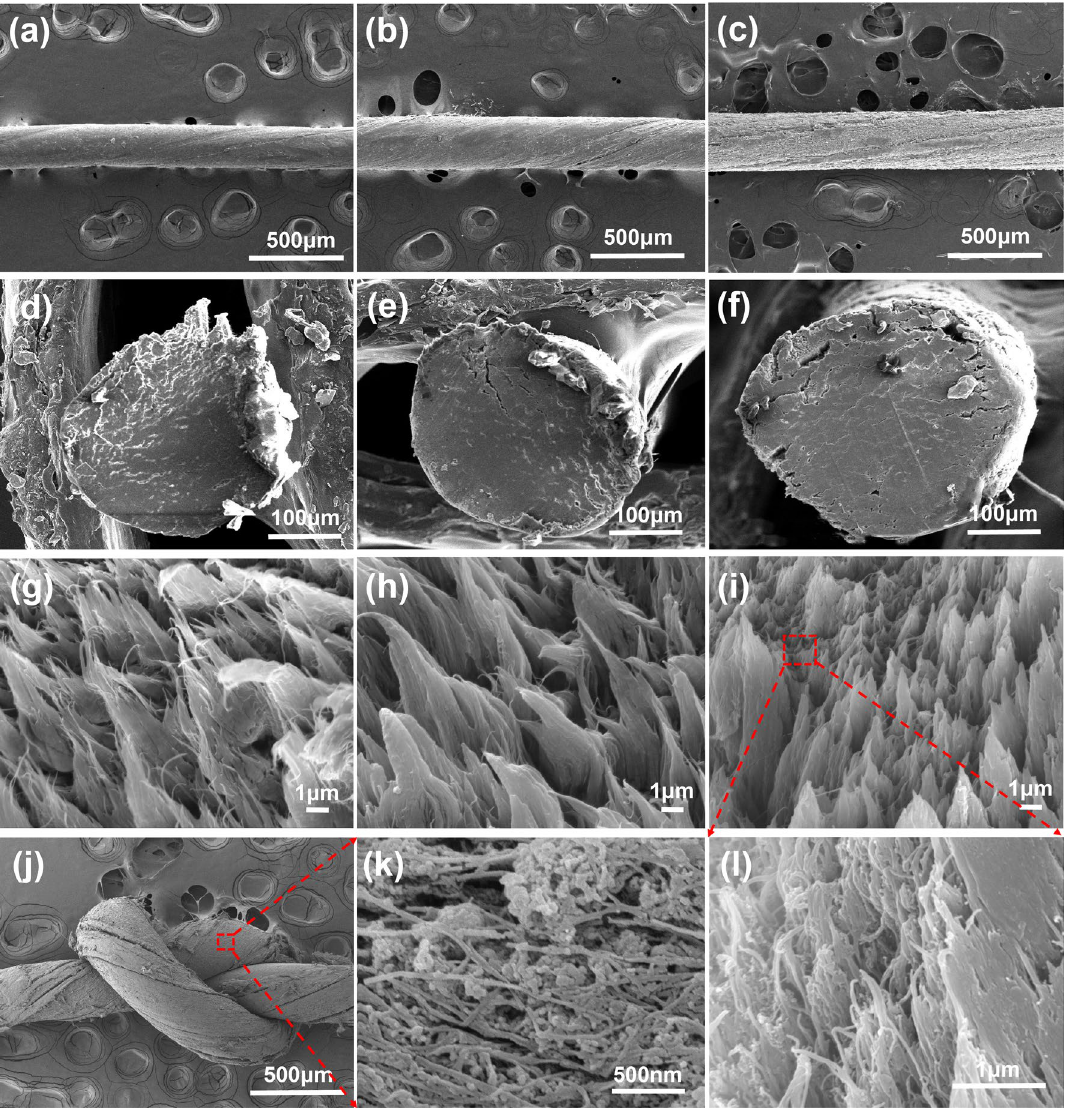
Fig. 2 SEM images of pure BC, BC/CNT, BC/CNT/PPy macrofibers. Surface morphology of a BC, b BC/CNT, c BC/CNT/PPy macrofiber. Fracture surfaces of d, g BC macrofiber, e, h BC/CNT macrofibers, f, i, l BC/CNT/PPy macrofibers. j Knotted BC/CNT/PPy macrofiber and k the